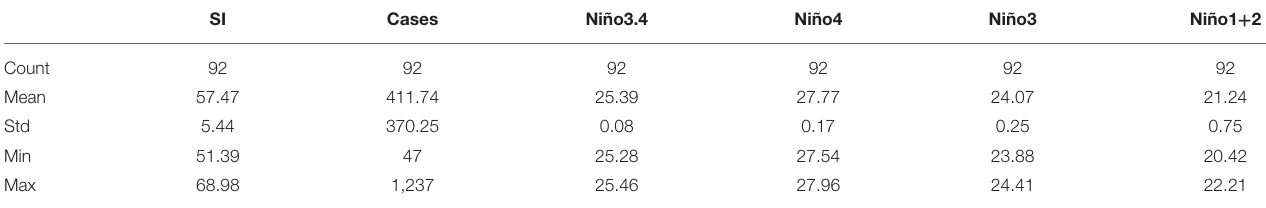
TABLE 1B | Descriptive statistics of the data used (October 1, 2020 to December 31, 2020).